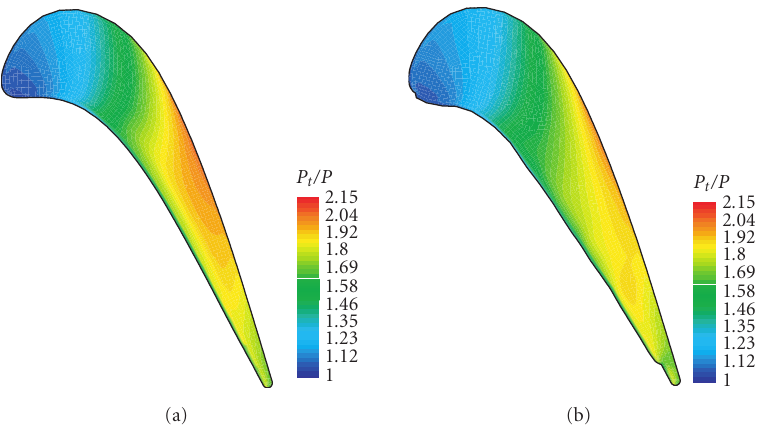
Figure 6: Contours of pressure ratio on the blade tip, (a) baseline flat tip and (b) desensitized flat tip.